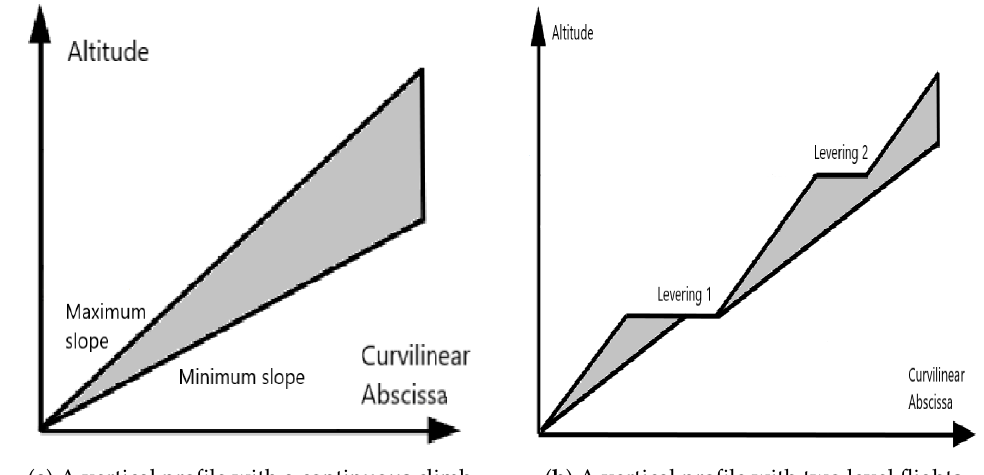
Figure 3. Illustration of the vertical profile z γ .